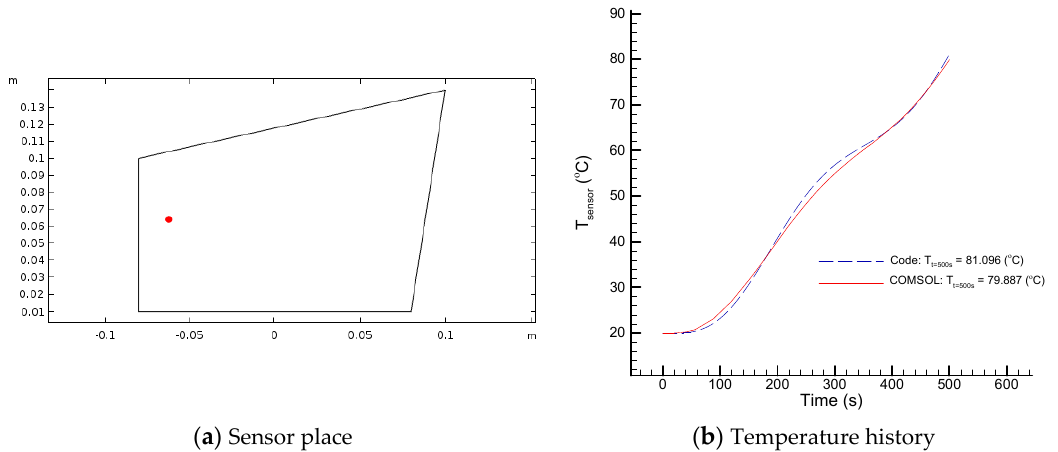
Figure 3. Validation of the direct problem solver using the finite element software COMSOL. The result obtained by using our explicit code ( a ) and the result obtained by using COMSOL ( b ).